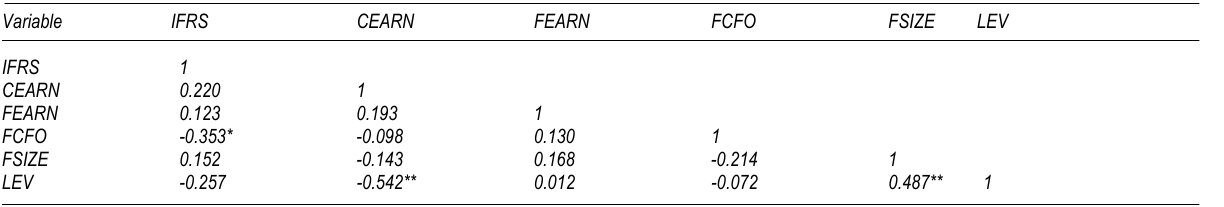
Table 2. Test of correlation matrix of the sampled variables